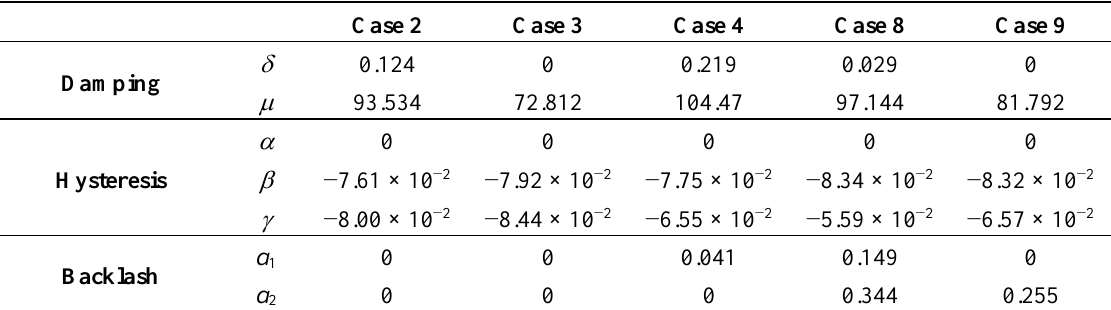
Table 7. Results for parameter estimation for the validation cases.